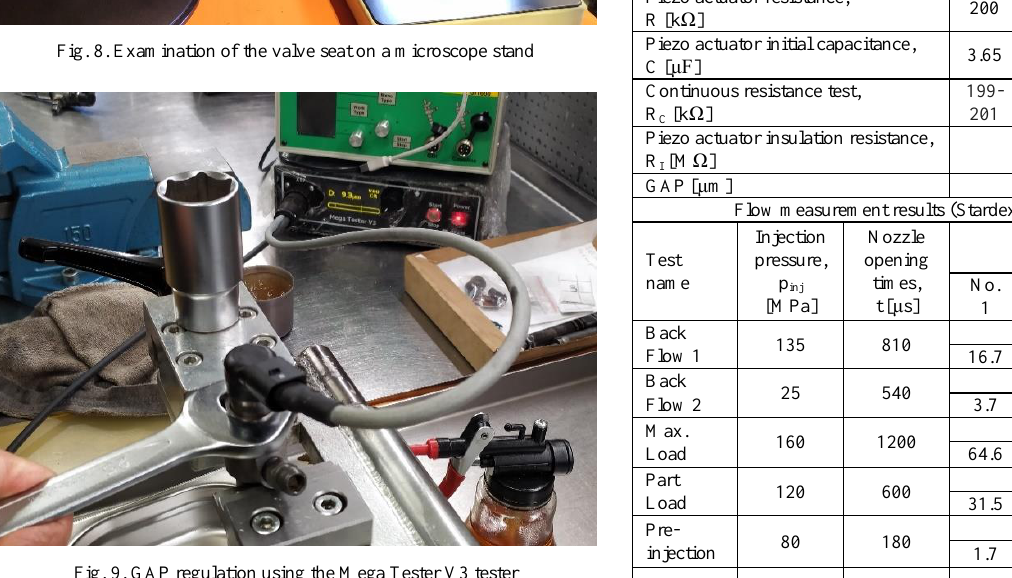
Fig. 9. GAP regulation using the Mega Tester V3 tester